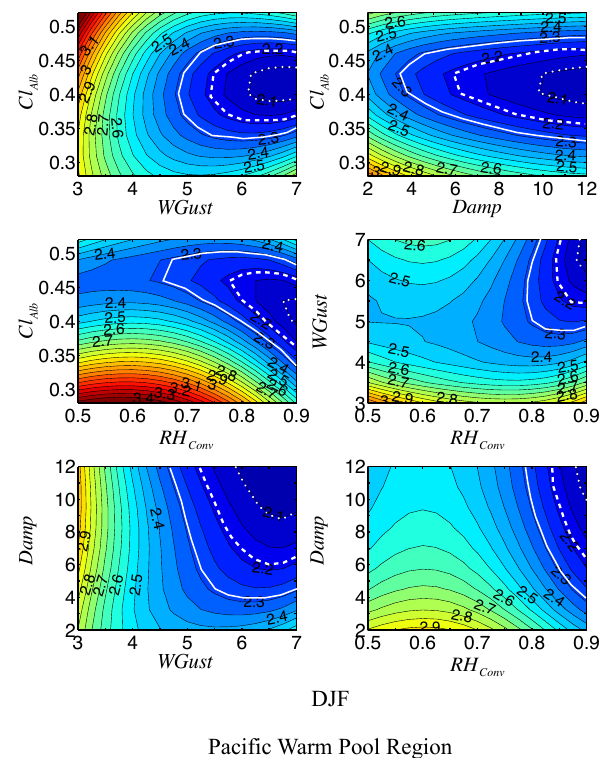
Fig. 12. As in Fig. 11 but for the Pacific Warm Pool